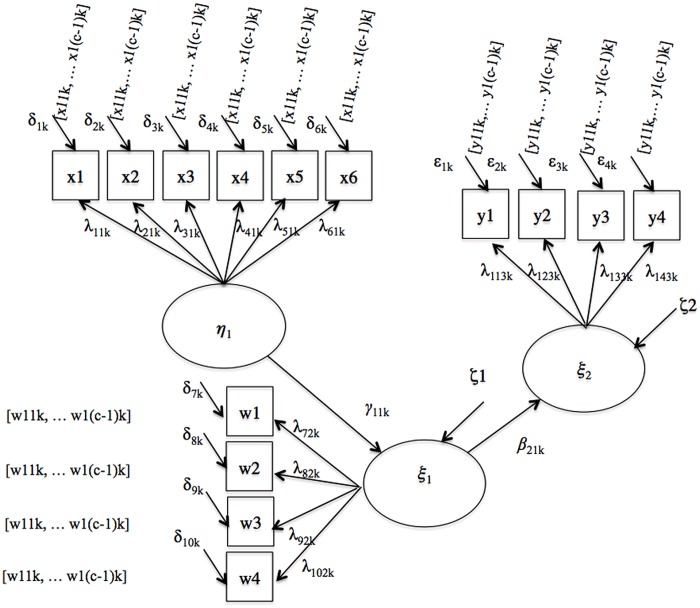
Mediated regression.